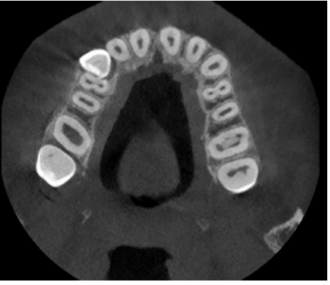
Figure 3. Patient’s plaster study models: ( a ) front image, ( b ) left-side image, ( c ) right-side image.